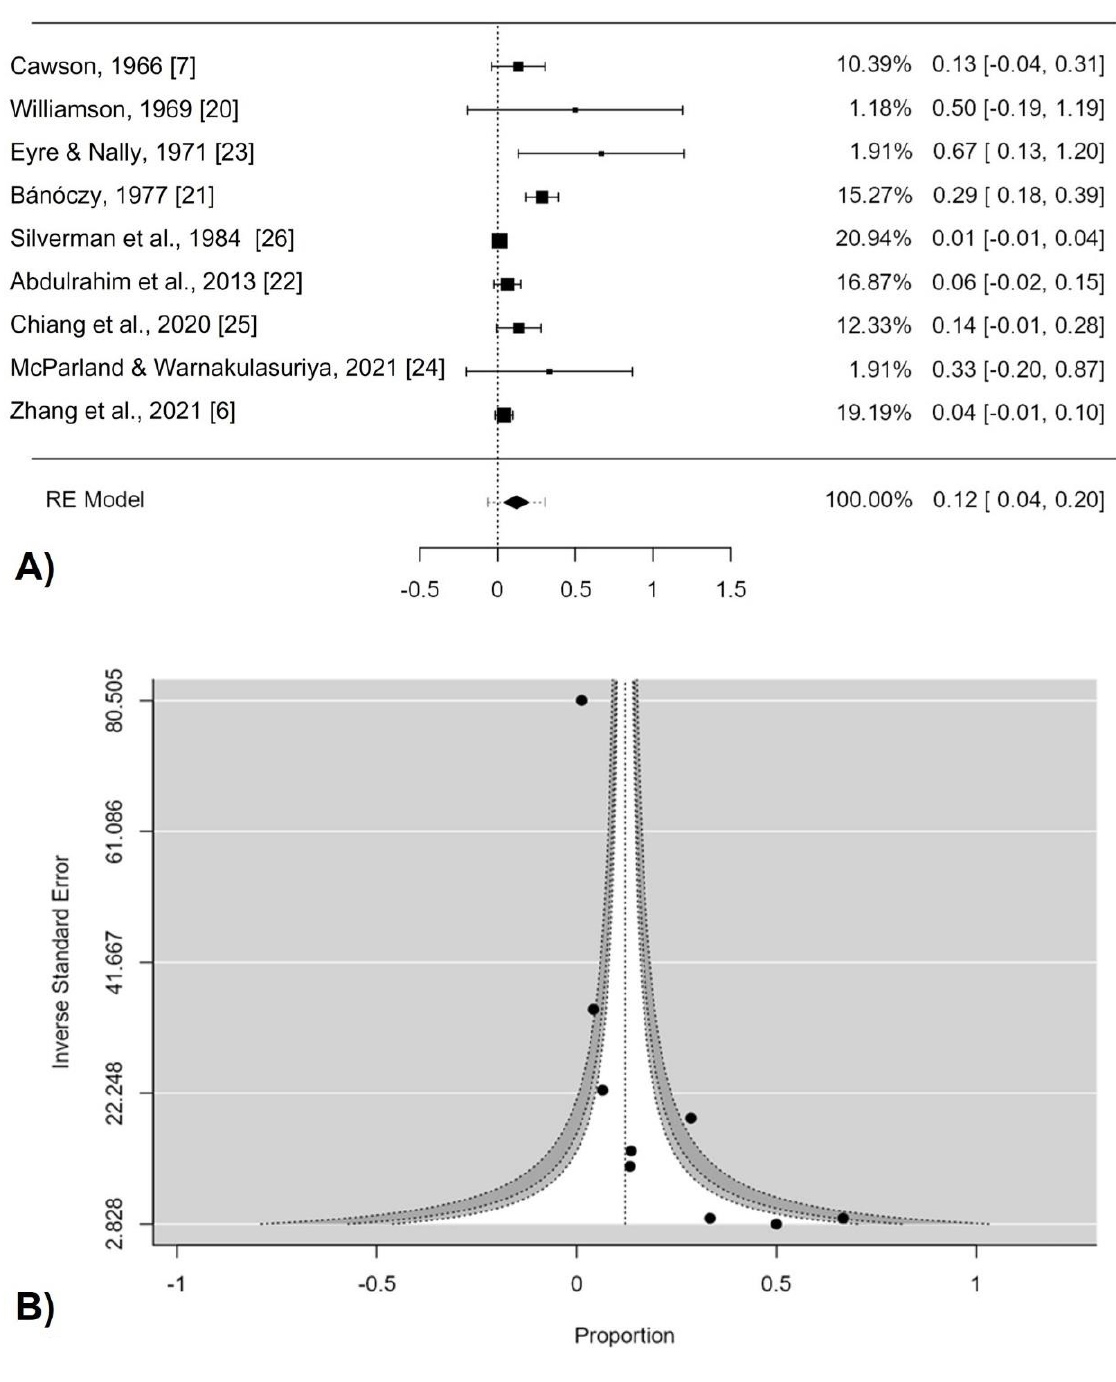
Figure 3. ( A ) Forest plot. Overall malignant transformation of chronic hyperplastic candidiasis. RE (random effects) and weight of each study; ( B ) Funnel plot assessing the publication bias [6,7,20 – 26].